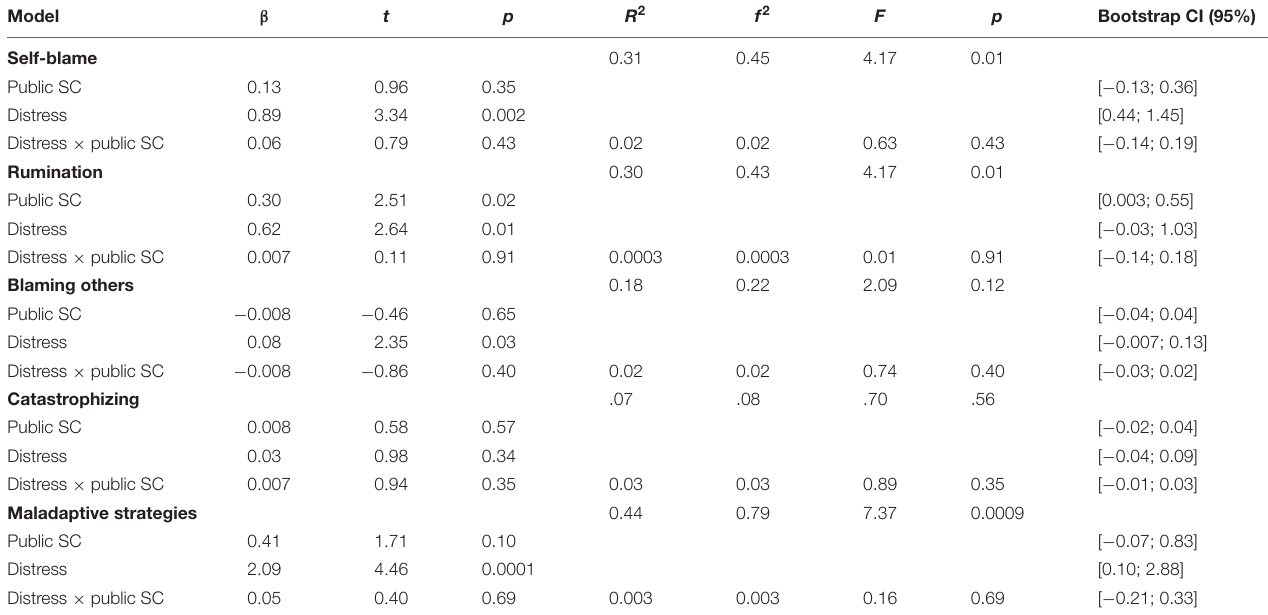
TABLE 5 | Multiple regression analyses predicting maladaptive emotion regulation strategies as a function of public SC, distress and their interaction in the binge drinking group.